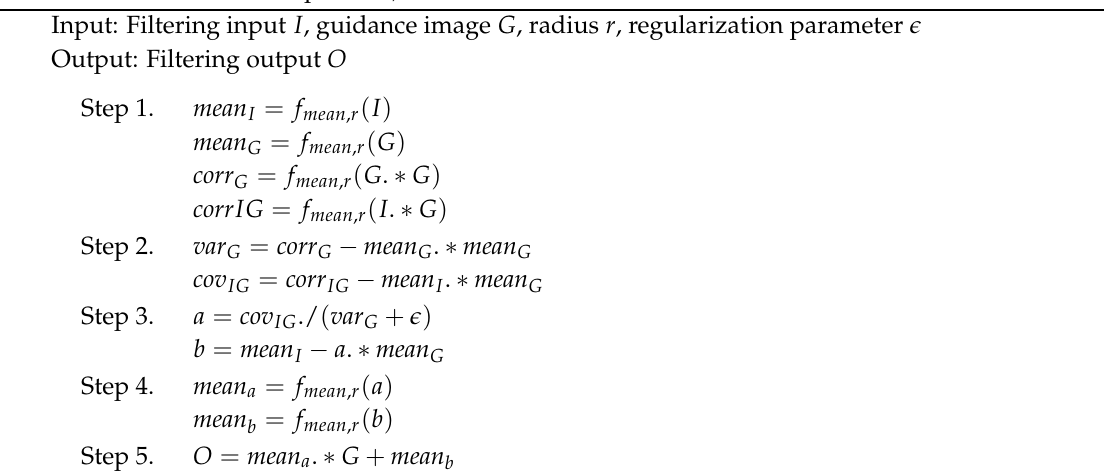
Algorithm 1: Guided image filter algorithm. Note: “. ∗ ” denotes point-wise multiplication (also known as the Hadamard product).